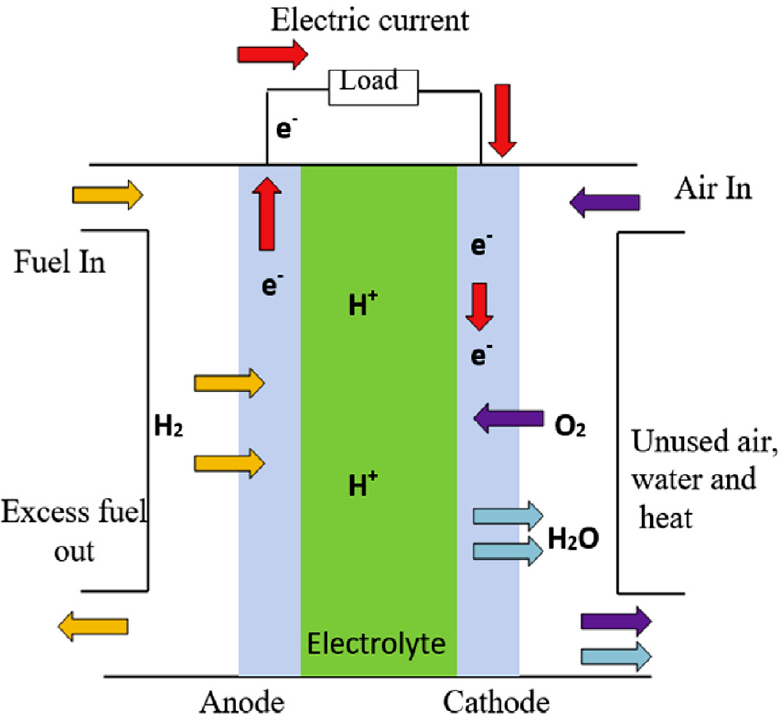
Figure 1. The working principle of PEMFC.